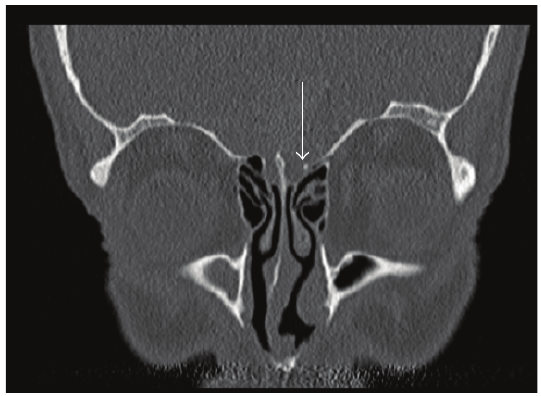
Figure 2: Ethmoid roof is “flattening” or shows a “broken wing” on the left side (arrow). Coronary CT scan of a patient with chronic sinusitis.